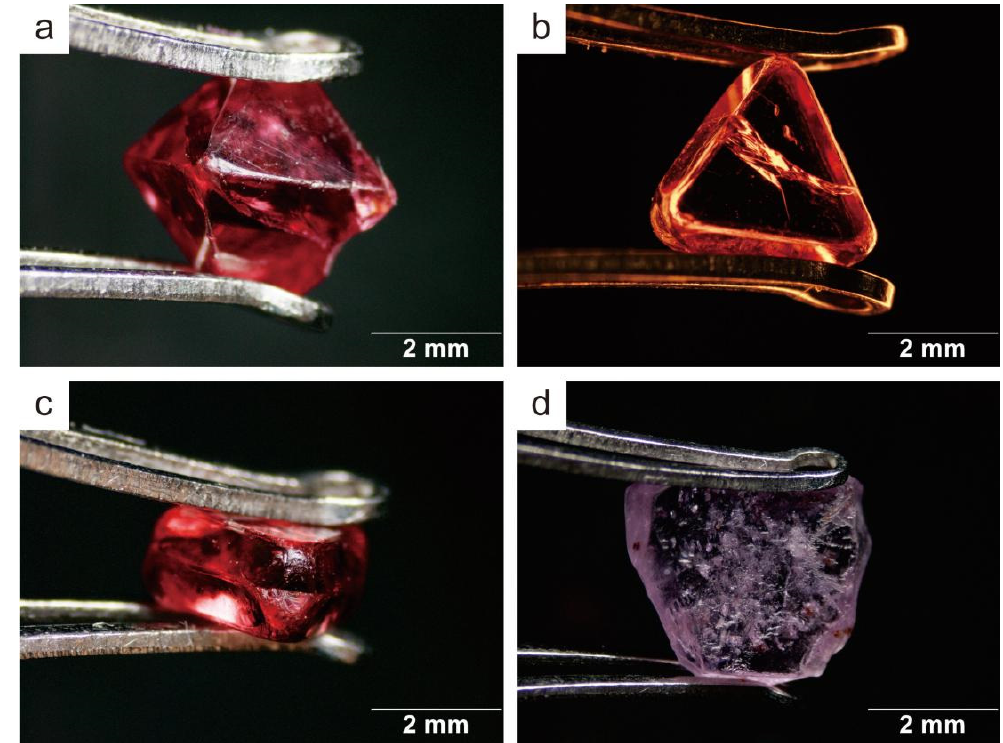
Figure 4. ( a ) Octahedral spinel from Myanmar (M − 1). ( b ) Spinel formed as spinel twins from Myanmar (M − 2). ( c ) Spinel formed as spinel twins with re-entrant angles from Myanmar (M − 2). ( d ) Slab spinel from Tajikistan (T − 4).